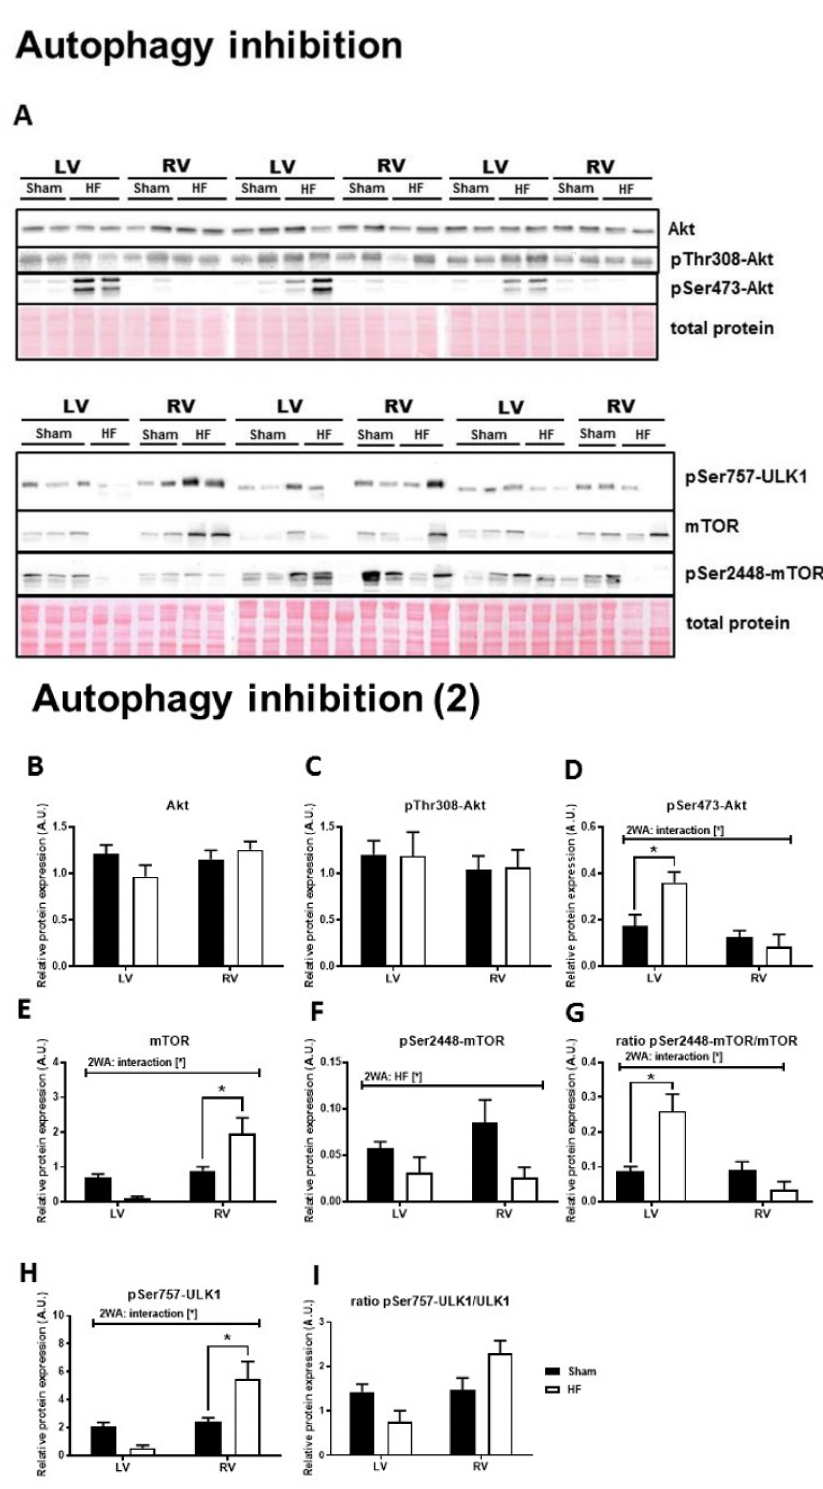
Figure 3. Analysis of inhibition of autophagic signaling in the left and right ventricle of rat hearts. ( A ) representative immunoblots and total protein staining; ( B – I ) Immunoblot quantification of Akt, pThr308-Akt, pSer473-Akt, mTOR, pSer2448-mTOR, ratio pSer2448-mTOR / mTOR, pSer757-ULK1, ratio pSer757-ULK1 / ULK1. Sham—sham-operated group; HF—group with post-myocardial infarction heart failure; LV—left ventricle; RV—right ventricle. Data are presented as mean ± SEM; n = 6–9 per group; 2WA—2-way ANOVA; “HF” factor—presence of heart failure; “V” factor—heart ventricle; “Interaction” of 2 factors. * p < 0.05 vs.